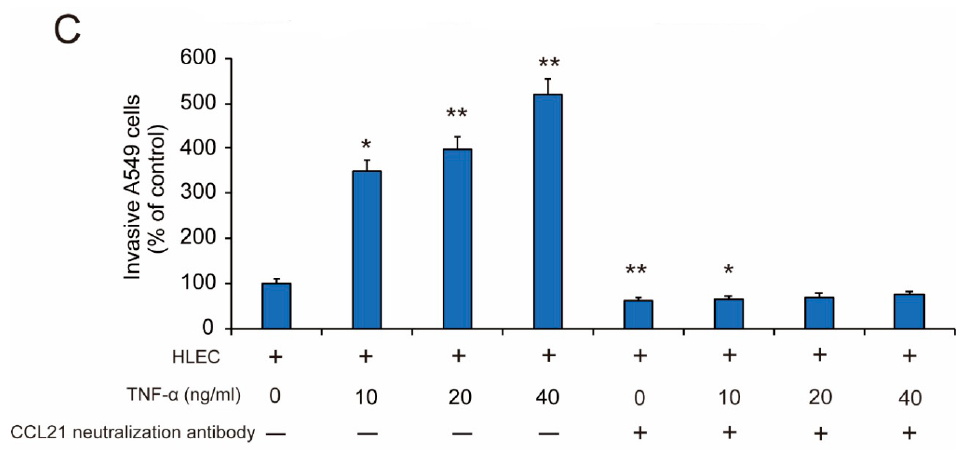
Figure 5. HLEC co-culture-induced metastasis and invasion of A549 cells is CCL21 dependent. HLEC were pretreated with or without the indicated concentrations of CCL21 neutralization antibody, and then exposed to different concentrations of TNF- α (10, 20, and 40 ng / mL) for 48 h. ( A ) Confirmation of the neutralized efficiency of CCL21 secretion was detected by ELISA analysis in HLEC. Data represent the mean ± S.E.M. from three independent experiments. Asterisks denote statistically significant (* p < 0.05 and ** p < 0.01) differences compared with controls by one-way ANOVA. ( B,C ) Afterwards, HLEC were exposed to the CCL21 neutralization antibody and different concentrations of TNF- α (10, 20, and 40 ng/mL) for 48 h, then the CCL21 neutralization antibody and TNF- α were removed and replaced with fresh medium to continue culturing for 48 h. Next, A549 cells were co-cultured with the above HLEC for 48 h. The invasive ability was evaluated by a matrigel-coated transwell invasion assay (image magnification: 200 × ). Each experiment was performed at least three times. Data are presented as means ± S.D. * p < 0.05 compared with the control group; ** p < 0.01 compared with the control group.